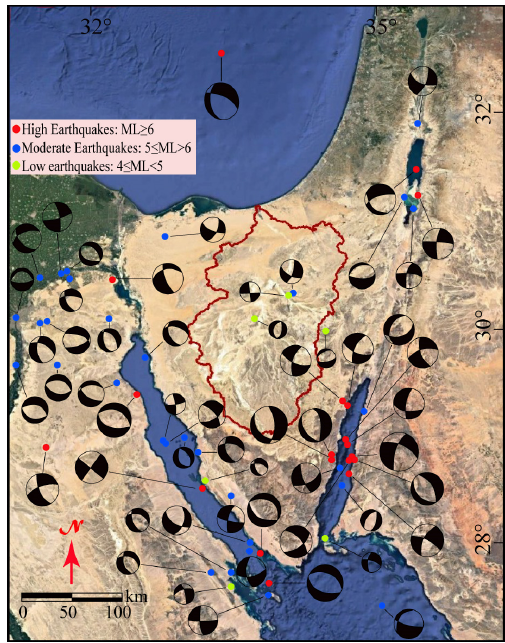
Figure 3. Distribution of historical and instrument-monitored earthquakes that have affected Sinai. The focal mechanisms are illustrated for each earthquake. The red polygon indicates Wadi Al-Arish area.